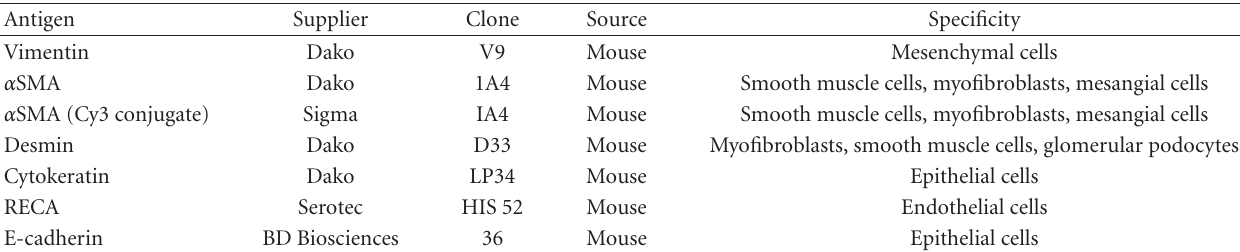
Table 1: Cytochemical markers of renal cell